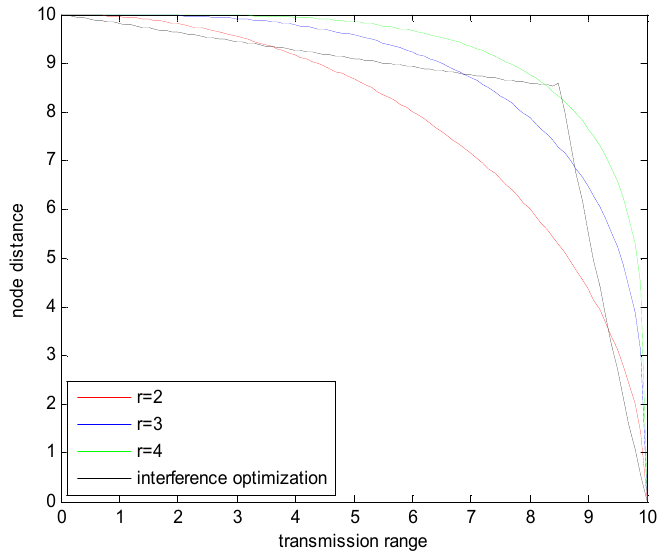
Figure 17. The boundary of energy-efficiency and interference-optimality in homogeneous networks.